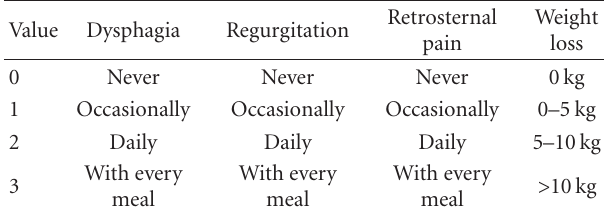
Table 2: Eckardt